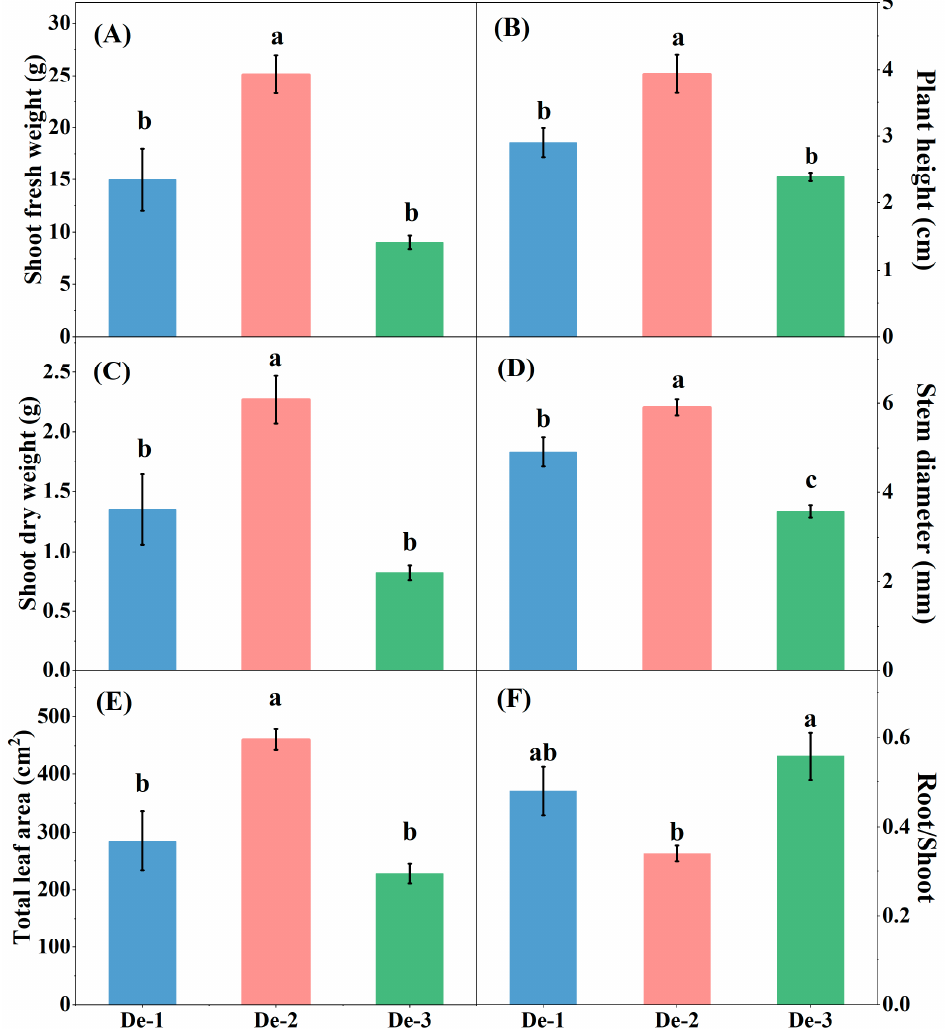
Figure 3. Agronomy traits of kale under different nutrient-solution depths as measured by ( A ) shoot fresh weight; ( B ) plant height; ( C ) shoot dry weight; ( D ) stem diameter; ( E ) total leaf area; and ( F ) the ratio of root and shoot. Different letters (a–c) marked upon the columns in the figure indicate significant differences between treatments by Duncan’s multiple ( p < 0.05), and vertical bars represent the standard margin of error.